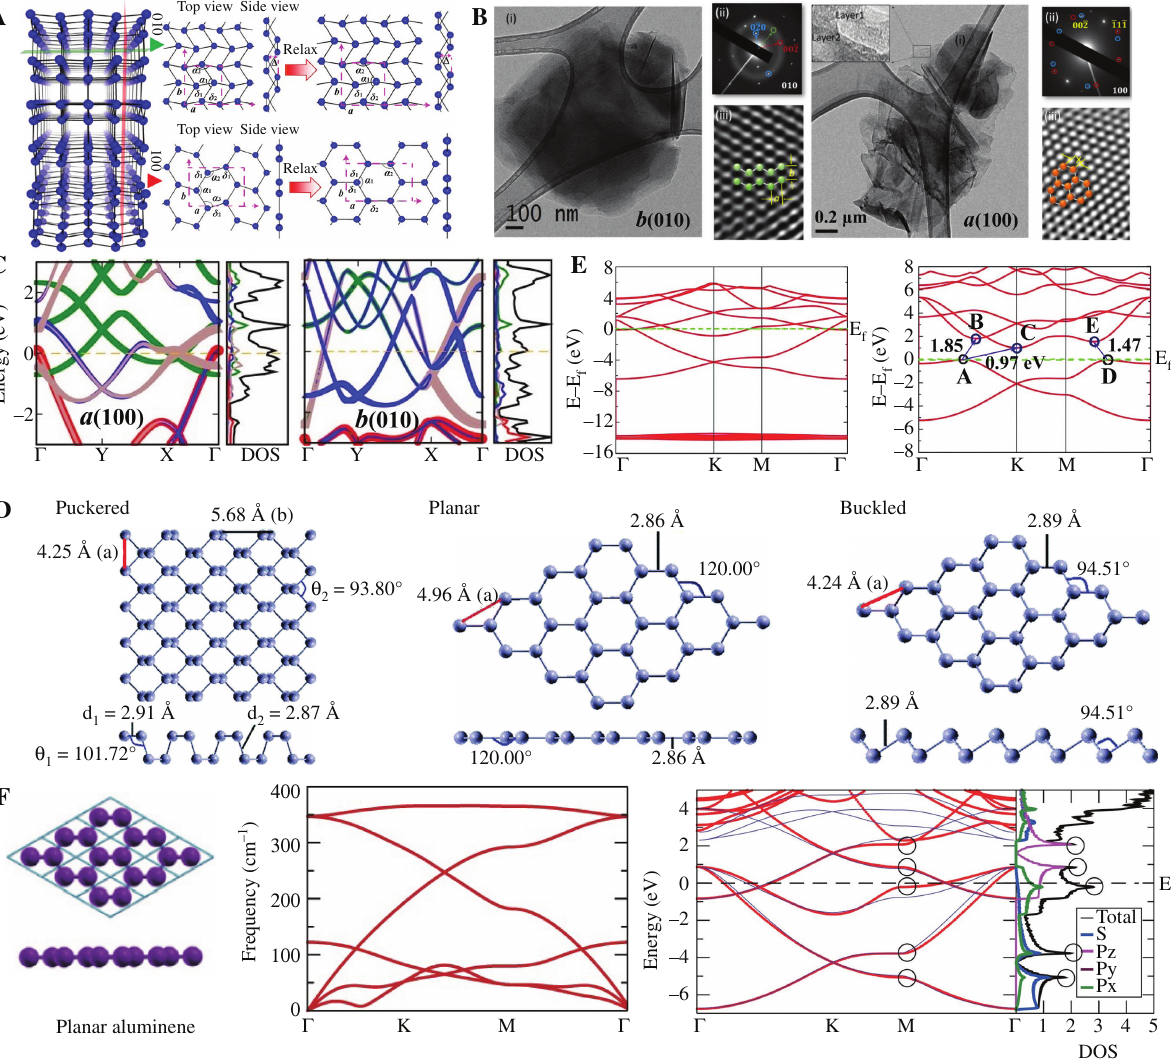
Figure 2: The geometric and electronic structures of gallenene, indiene, and aluminene polymorphs. (A) The crystal structure of bulk α -Ga (left) and the atomic configurations of monolayer gallenene cleaving along the (010) and (100) direction before (middle) and after relaxation (right). Gallenene cleaved along (010) direction forms a distorted rhombic lattice, while that cleaved along the (100) direction forms a honeycomb lattice. (B) Representative brightfield TEM, SAED, and HRTEM images for the a (100) and b (010) gallenene nanosheets. (C) Band structure and density of states for a (100) and b (010) gallenene monolayers. Reproduced with permission [62]. Copyright 2018, American Association for the Advancement of Science. (D) The optimized geometries of puckered, planar and buckled indiene. (E) The electronic band structures of stable planar and buckled indiene. Reproduced with permission [63]. Copyright 2016, The Royal Society of Chemistry. (F) The optimized geometries (left), phonon dispersion (middle), and electronic band structure as well as DOS (right) for planar aluminene. Reproduced with permission [64]. Copyright 2015, IOP